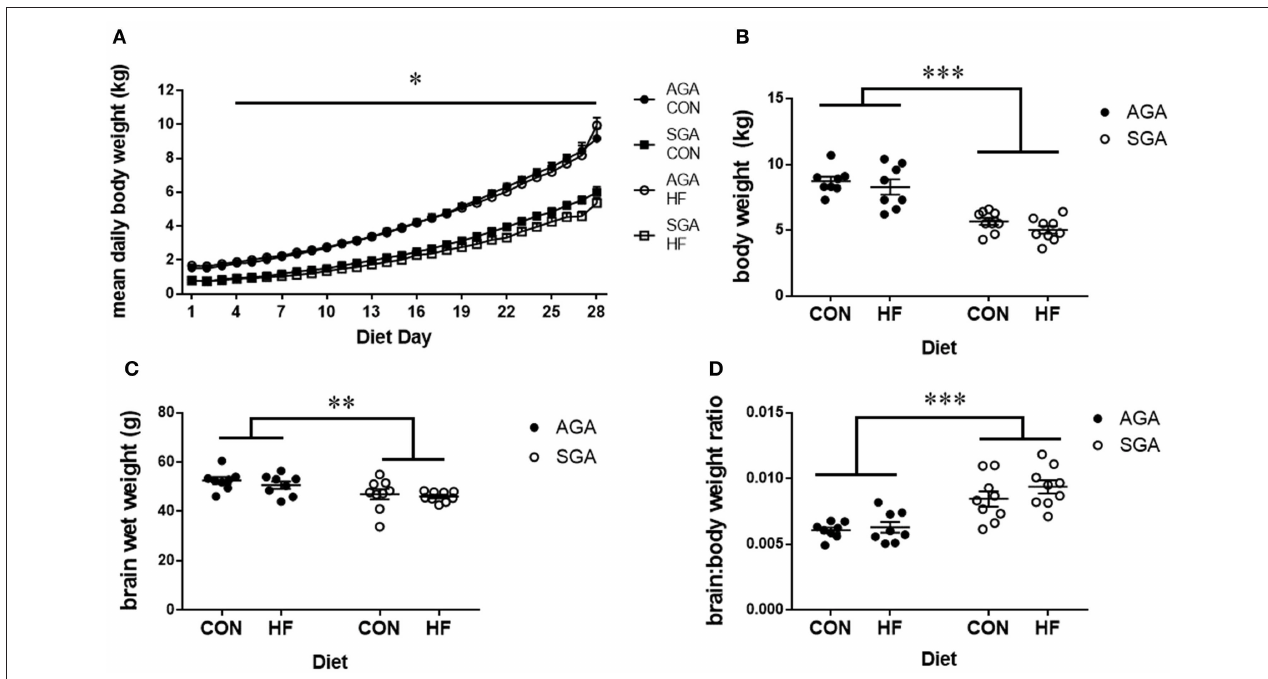
FIGURE 2 | Brain and body weights of piglets fed a control or HF formula. Body weight was measured each morning (A) . SGA piglets gained weight in a similar pattern but a slower rate than AGA. AGA piglets began gaining weight at day 4, while SGA piglets did not show appreciable weight gains until day 7. AGA piglets outweighed SGA piglets every day for the remainder of the study starting at day 4. Diet did not affect piglet weight gain. SGA piglets weighed less than AGA on the day of MRI regardless of diet (B) . Brain weights taken after the MRI showed that SGA piglets had smaller brains (C) . The brain to body weight ratio was greater in SGA piglets. There were no effects of diet on brain weights or brain to body weight ratio (D) . AGA, appropriate for gestational age; SGA, small for gestational age; CON, control; HF, hydrolyzed fat. Data are presented as mean ± SEM, AGA n = 8 per group, SGA n = 9 per group. *** p < 0.001, ** p < 0.01, * p <